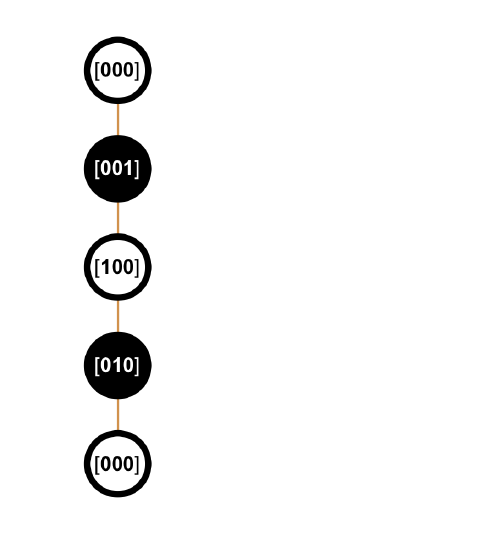
Figure 14 . Adinkra Diagram for 6D (1 , 0)